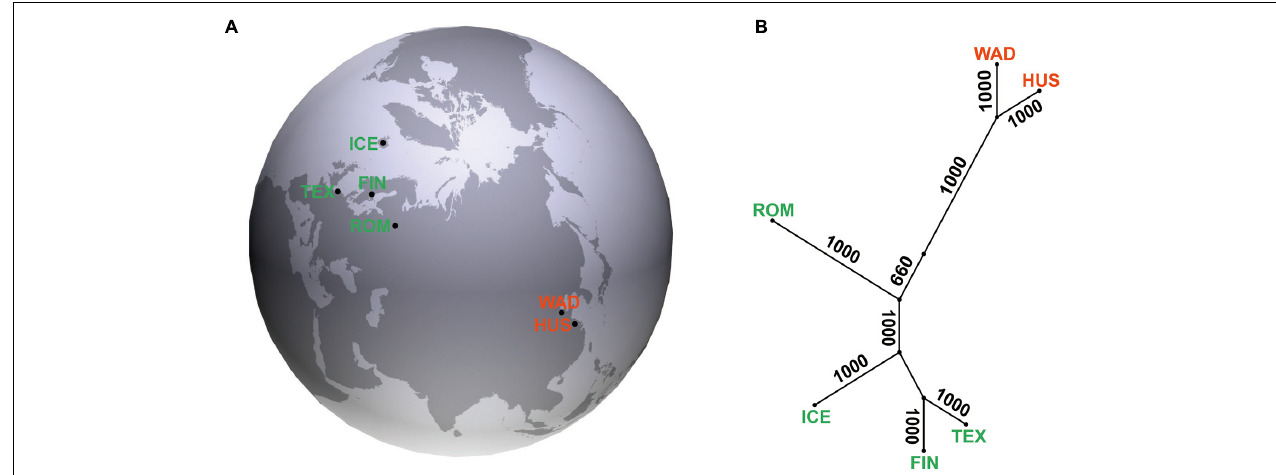
FIGURE 1 | (A) Geographic locations for five sheep breeds of high (WAD, Wadi sheep; HUS, Hu sheep; ICE, Icelandic sheep; FIN, Finnsheep; and ROM, Romanov sheep) and one low (TEX, Texel sheep) prolificacy. (B) Neighbor-joining tree of the six sheep breeds with 1000 bootstrap replicates.